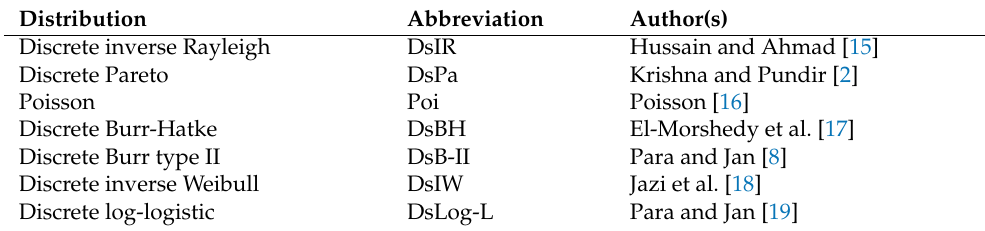
Table 5. The CMs of the NDsLE model.